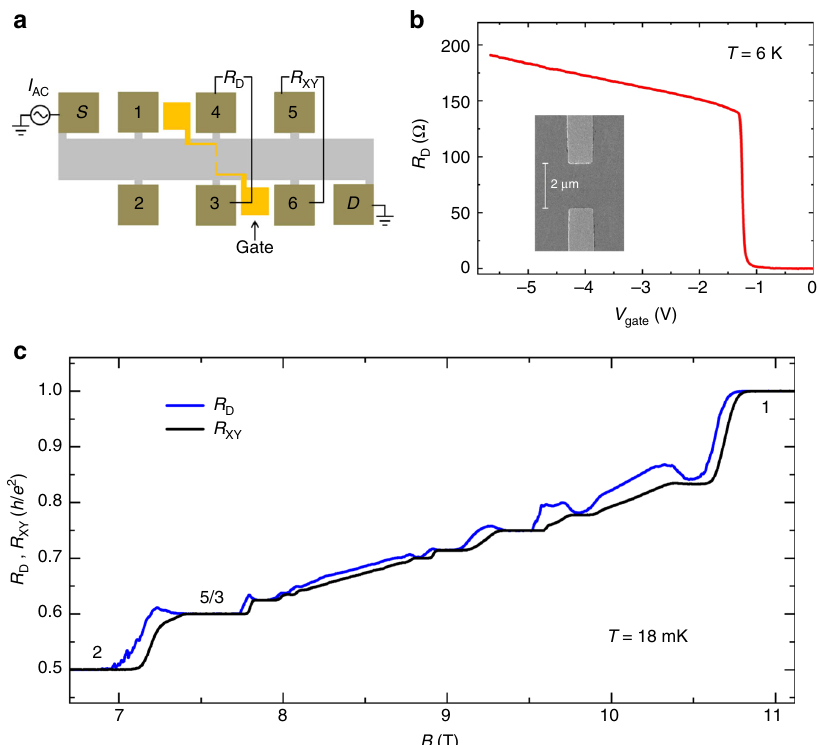
Fig. 1 Sample information and the diagonal resistance and the Hall resistance traces. a A sketch of the Hall bar and the measurement setup. b Gate voltage dependence of the diagonal resistance R D at B = 0 T and T = 6 K. The inset is an SEM picture of a device with the same gate geometry as that used in this experiment. The lithography dimension is 1 × 2 μ m 2 . c The diagonal resistance and the Hall resistance traces with V gate = − 4.5 V at 18 mK. The black line is the Hall resistance R XY and the blue line is the diagonal resistance R D . Both of them develop a series of IQH and FQH plateaus. R D was measured from contact 3 to contact 4, and R XY was from contact 6 to contact 5. Source data are provided as a Source Data fi